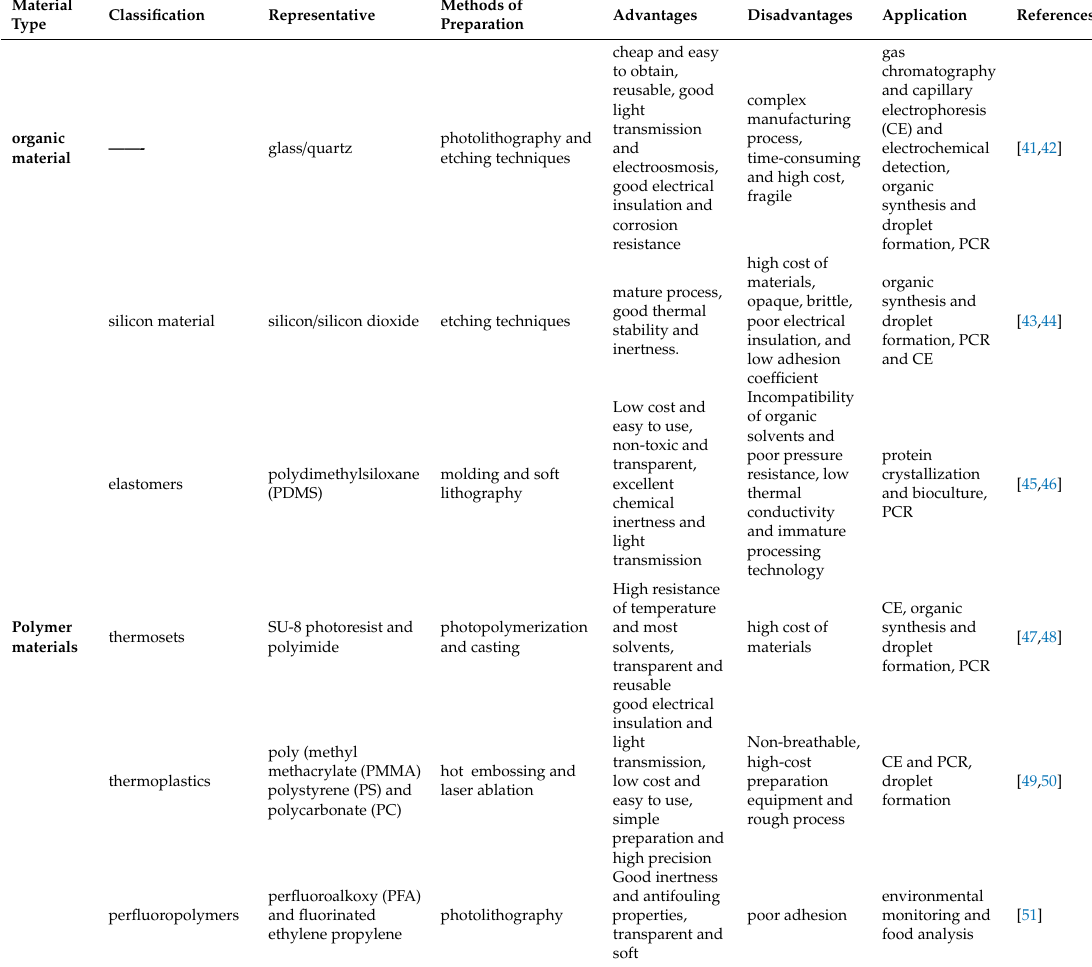
Figure 2. The preparation process of a polydimethylsiloxane (PDMS) microfluidic chip by the molding method. Table 1. The application of a microfluidic system made of different materials.